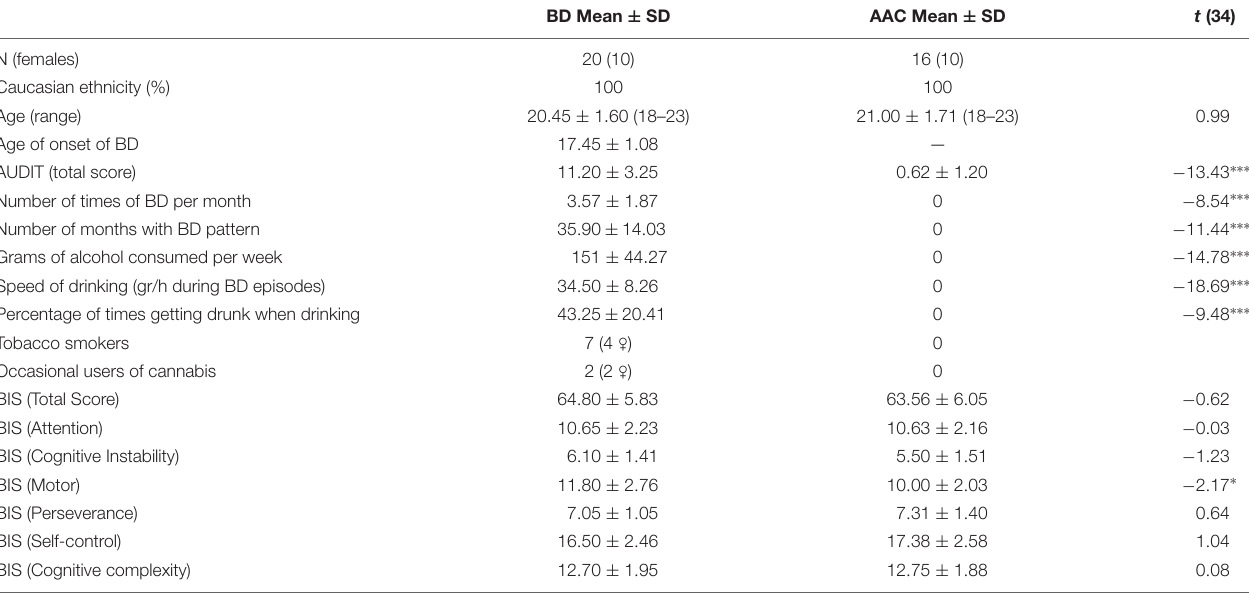
TABLE 1 | Demographic and behavioral data for BDs and